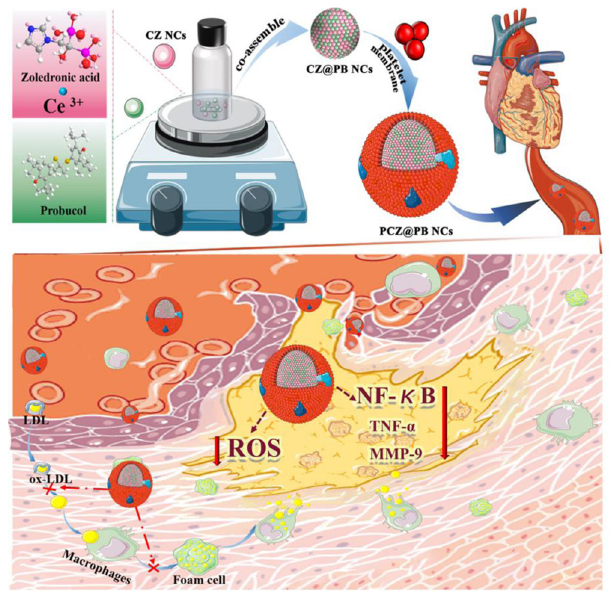
Fig. 1 | The preparation and application of the nanozyme (platelet membrane- coated biomimetic nanoplatform, PCZ@PB NCs). Biomimetic probucol-loa- ded nanozyme is obtained by assembly of zoledronic acid, cerium ions and pro- bucol and encapsulated in the platelet membranes. After administration, the PCZ@PB NCs were enriched to plaques through passive accumulation as well as active targeting of in fl ammatory lesions, reducing foam cell formation, resisting in fl ammation and removing excess